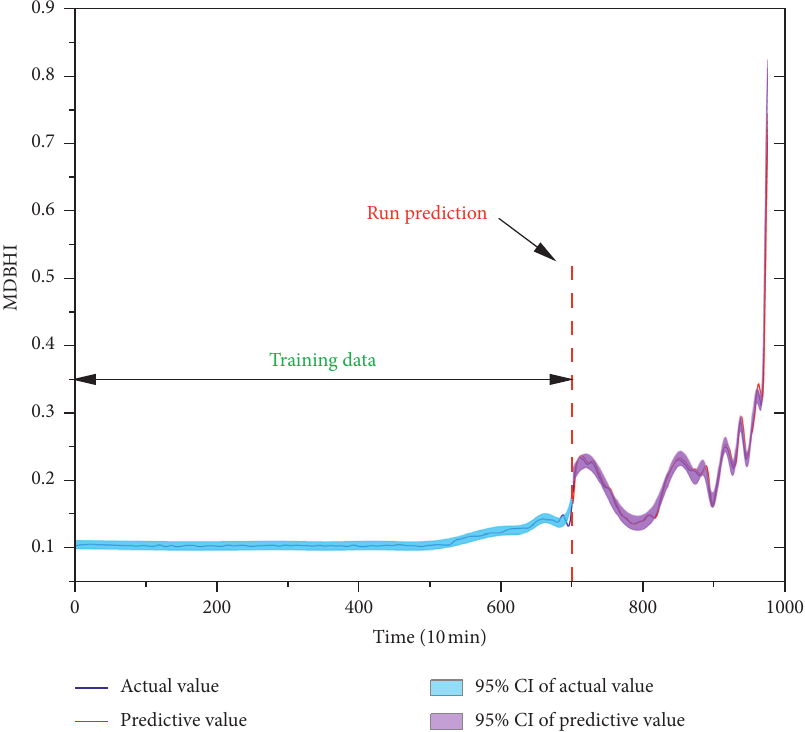
Figure 16: Confidence intervals for the prediction results of the proposed